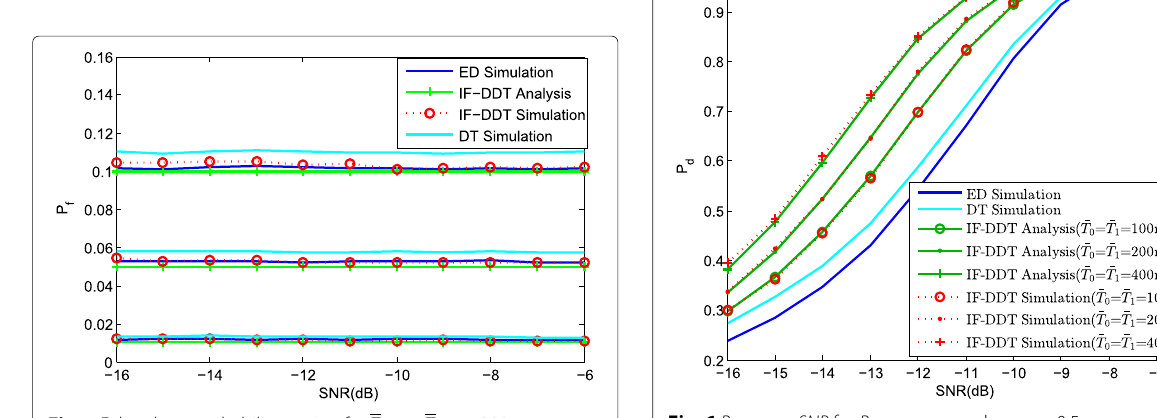
Fig. 6 P d versus SNR for P f ,target = 0.1 and η PU =